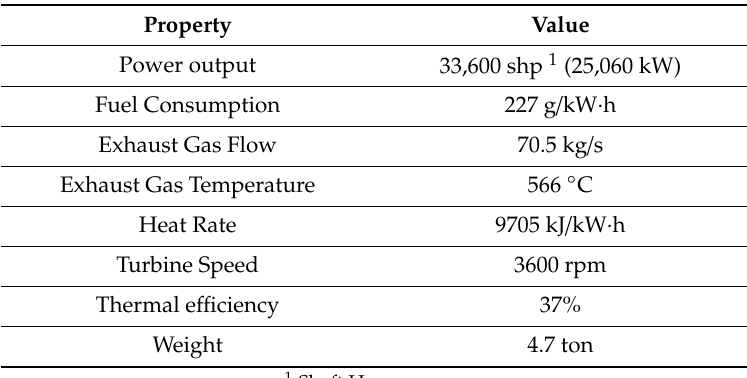
Table 1. LM2500 characteristics.